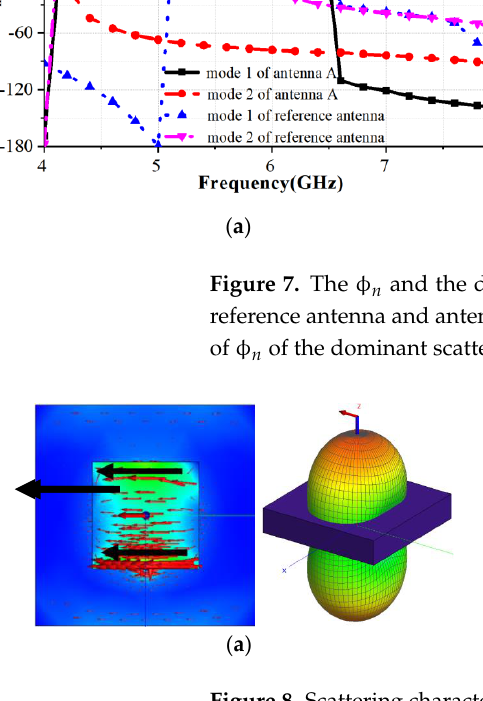
Figure 8. Scattering characteristic current distribution and far − field patterns comparison at 4.4 GHz. ( a ) Mode 1 of the reference antenna; ( b ) mode 1 of antenna